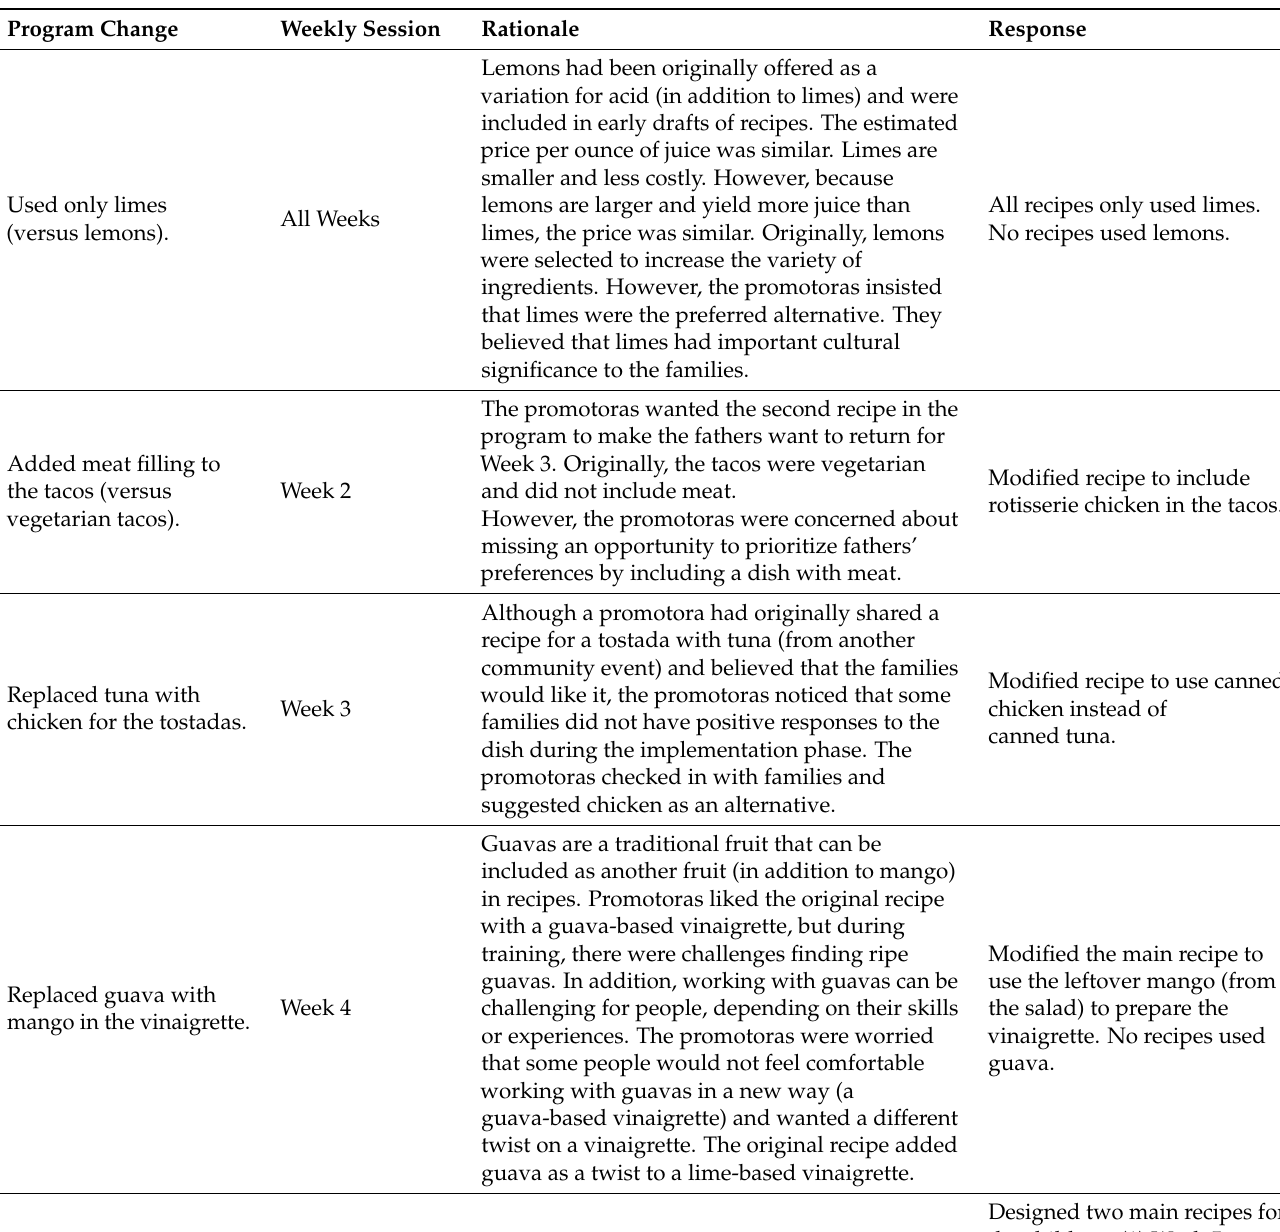
Table 1. Selected examples of content changes to nutrition curriculum made in collaboration with the